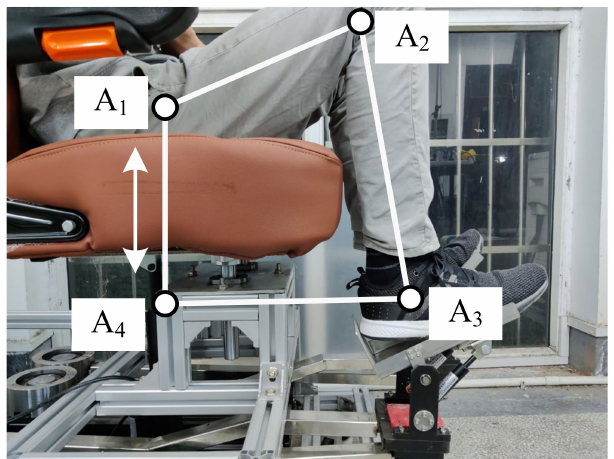
Figure 5. Closed loop